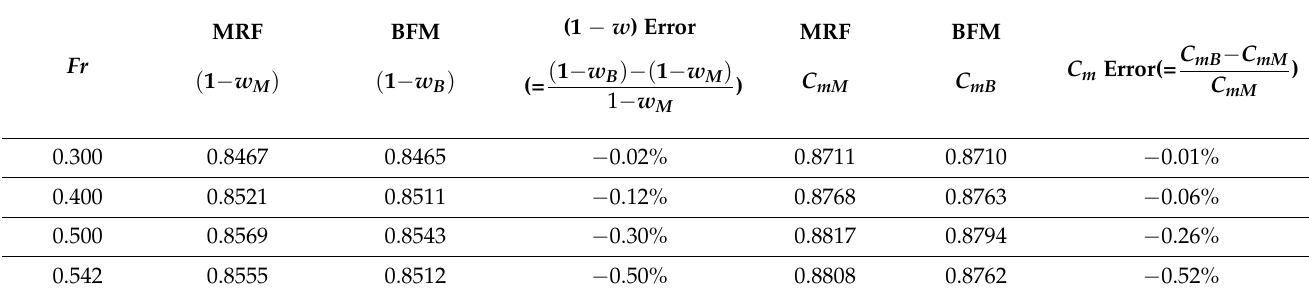
Table 5. Calculation ( 1 − w ) and C m of the capture area with the MRF model and body-force model.